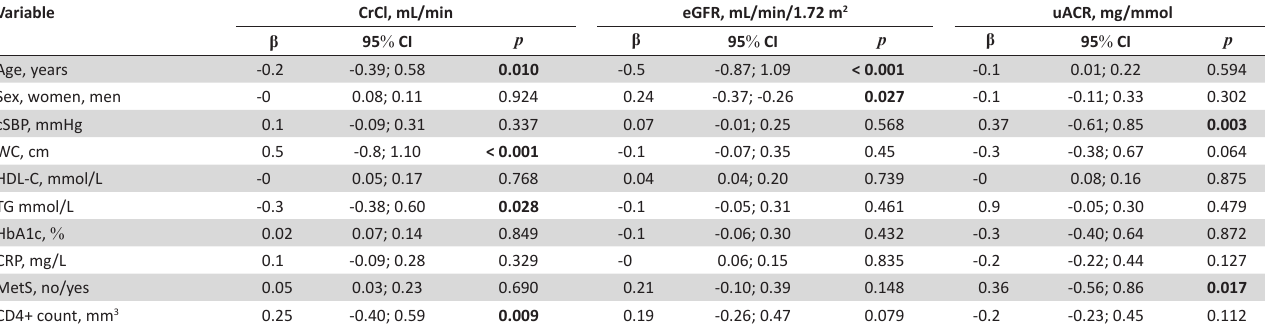
TABLE 3-A1: Multiple regression analysis with markers of renal function as dependent variables, after excluding individuals not using ART.